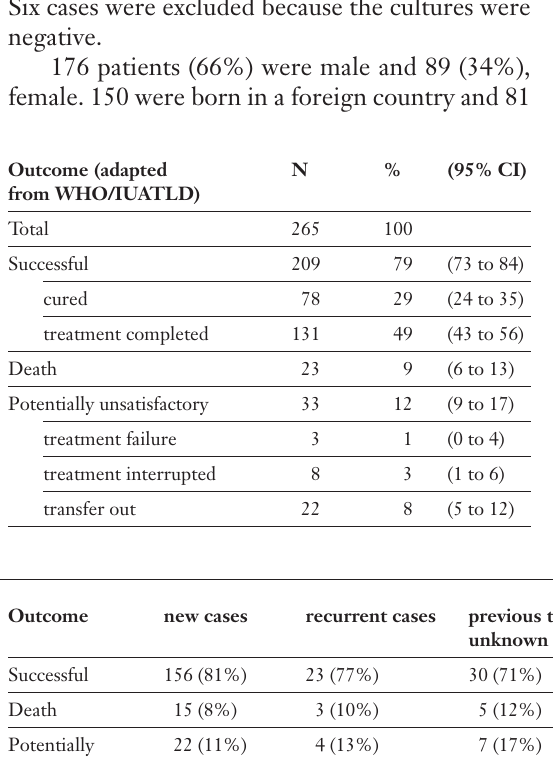
Treatment outcome by history of previ- ous TB treatment and sex.